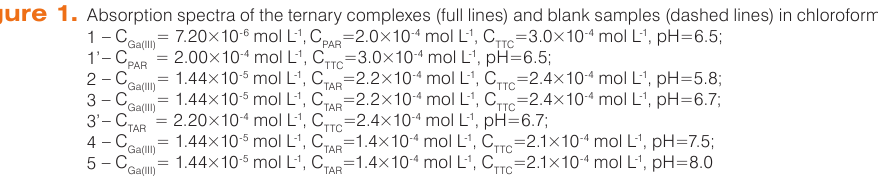
Figure 1. Absorption spectra of the ternary complexes (full lines) and blank samples (dashed lines) in chloroform. –